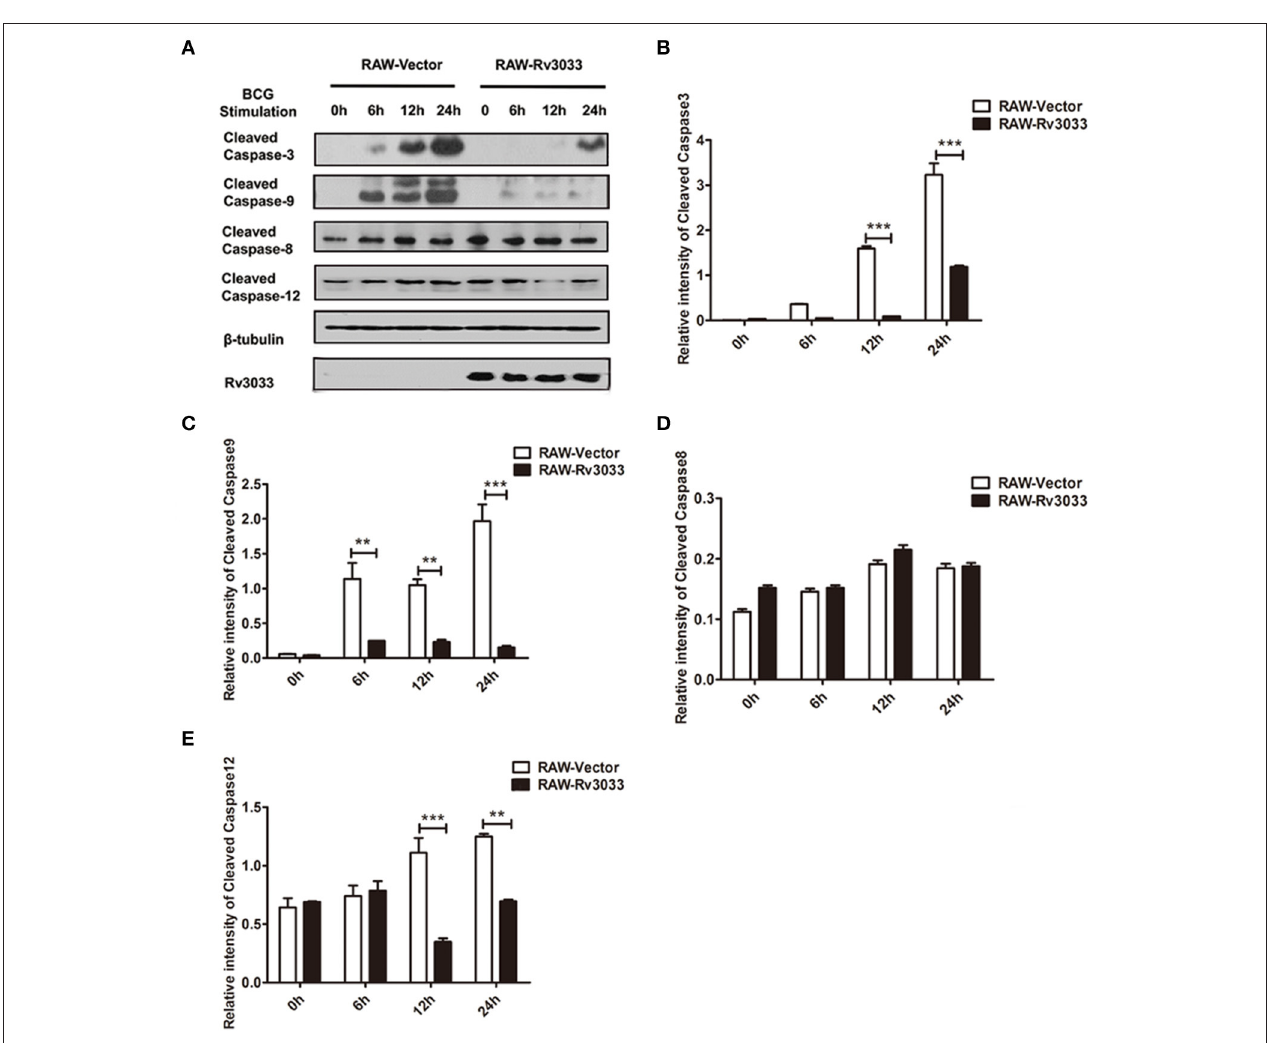
FIGURE 4 | Rv3033 suppressed mycobacteria-induced macrophage apoptosis by inhibiting the intrinsic apoptotic, but not the extrinsic apoptotic pathway. (A) RAW-Vector and RAW-Rv3033 cells were infected with BCG (MOI = 10) for 6, 12, or 24h. Cleaved caspase-3, cleaved caspase-9, cleaved caspase-8, and cleaved caspase-12 protein levels were determined by western blot analyses. (B–E) Semi-quantification of cleaved caspase-3, cleaved caspase-9, cleaved caspase-8, and cleaved caspase-12. Data are performed as the mean ( ± SEM) and from one representative experiment of three independent experiments. (** p < 0.01; *** p < 0.001).